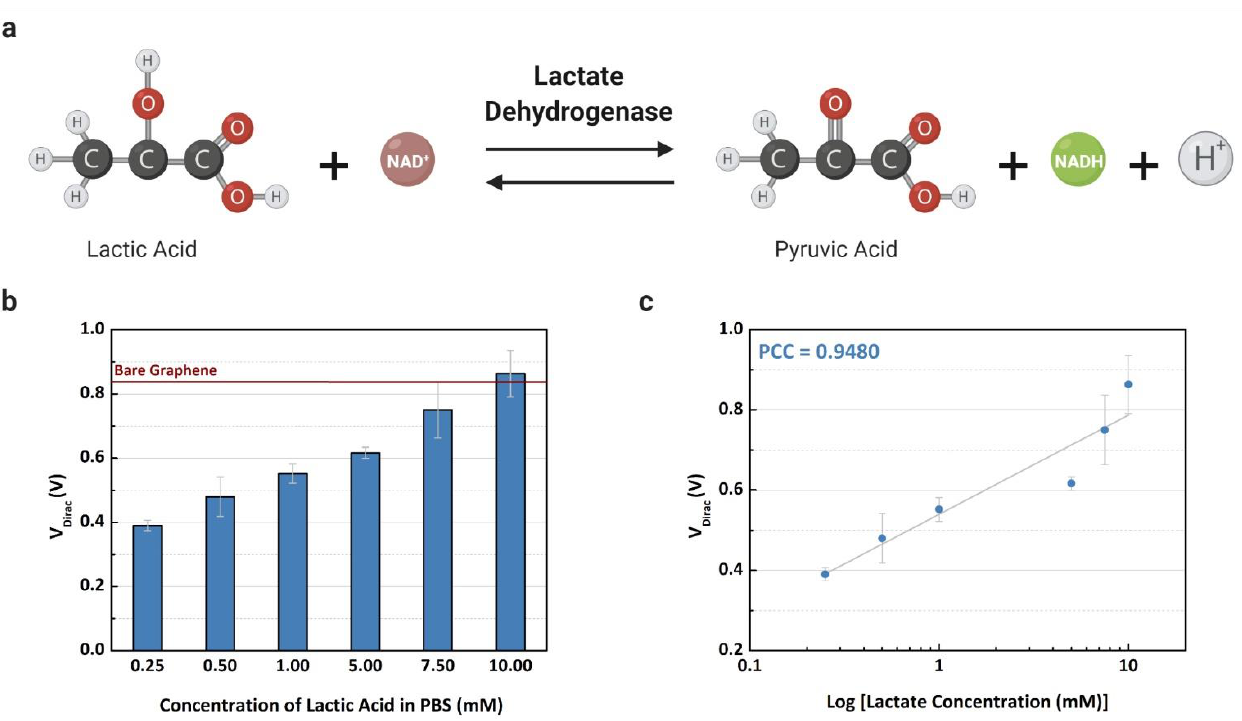
Figure 5. Experiments using the common-gate GFET device to detect L-lactic acid on buffer solution: ( a ) electrochemical reaction for the lactate assay; ( b ) the mean Dirac point (V Dirac ) (n = 3) concentration of L-lactic acid (0.25 to 10 mM); and ( c ) the linear fit of the measured concentrations with a Pearson correlation coefficient of 0.9480 (R 2 = 0.8735).